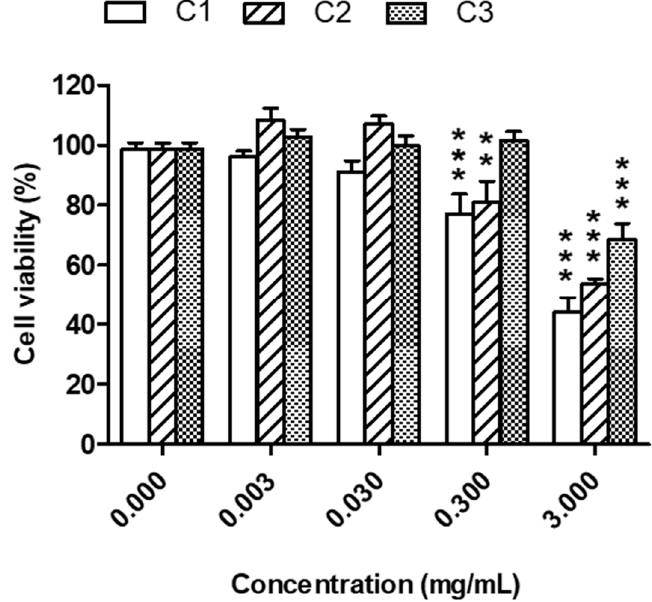
Figure 3. Cytotoxicity of C1, C2 and C3 extracts in HaCaT cells. Cells were treated with various concentrations of extract (0.003–3 mg/mL) for 24 h. At the end of treatment, cell viability was evaluated by MTT assay, as described in the method section. Data are expressed as percentage of control cells and expressed as mean ± SEM of four independent experiments (** p < 0.01 and *** p < 0.001 vs. cells untreated; one-way ANOVA with Dunnett post hoc test).